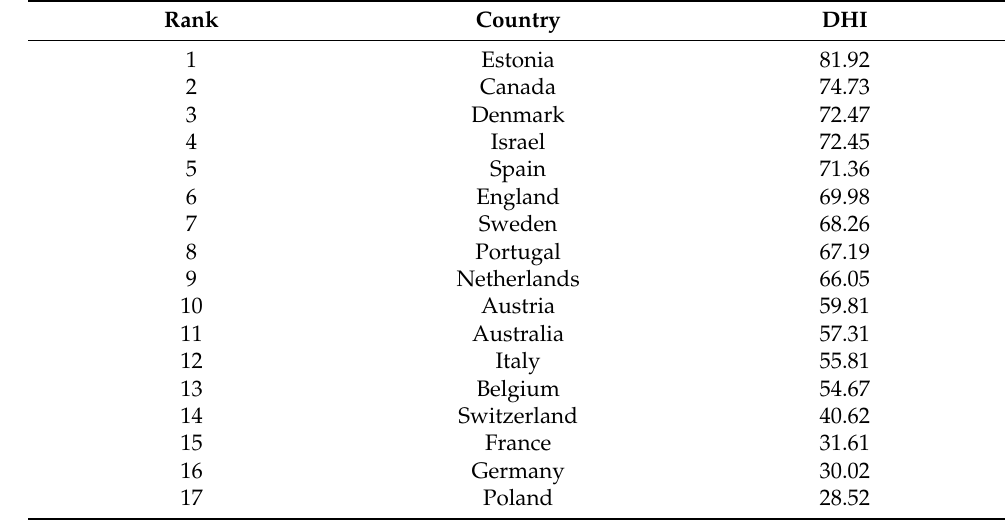
Table 1. Digital-Health-Index. Source: Own compilation based on data of Bertelsmann Foundation [58].